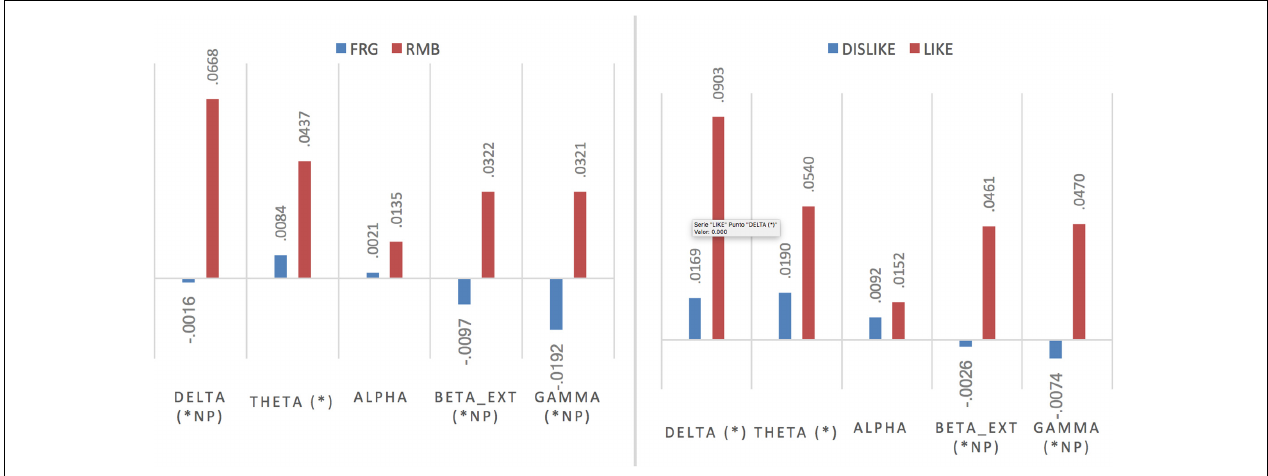
FIGURE 3 | Results from brain response (EEG) comparing GFP results for 5 specific bands ( ∗ values with significant differences p < 0.005; NP, non-parametric test carried out).